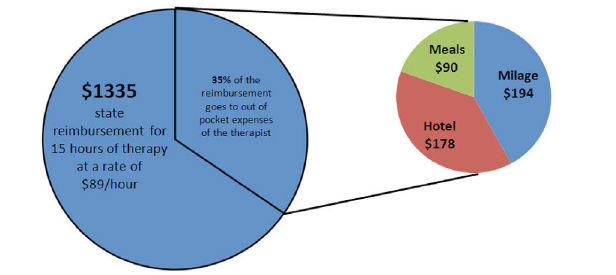
Figure 4 – Cost incurred for travel from Louisville to